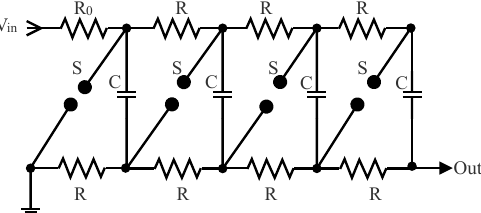
Figure 1. Classical Marx generator with negative